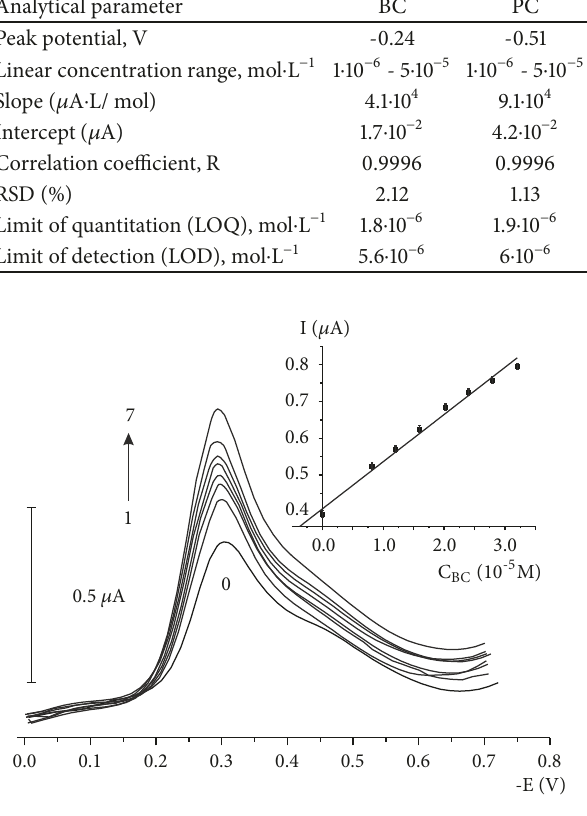
Figure 8: Polarogramms for the pharmaceutical dosage Septolete plus analysis with declared content of 5 mg BC using standard addition method. The corresponding standard additions: from 0.10 mL to 0.80 mL (C BC = 1 ⋅ 10 −3 mol L −1 ). The quantification of BC by standard addition method is depicted in the